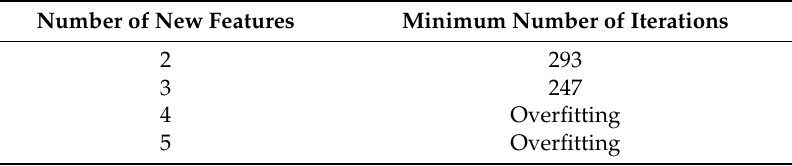
Table 15. Test results of new features with 150